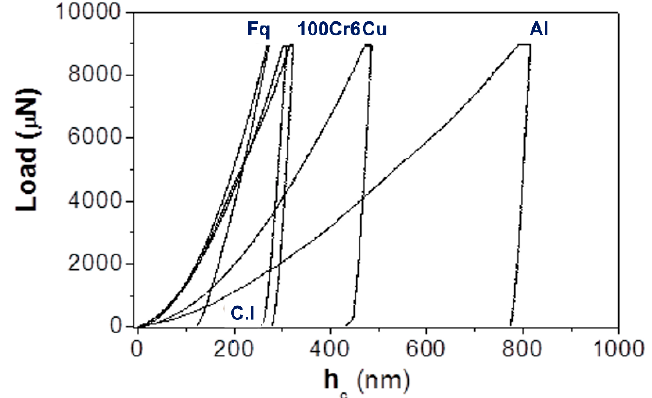
Figure 5. Load ‐ displacement curves (P Max = 9,000 μ N) for Fq, pure Al, DHP Cu, 100 Cr6 steel, grey cast iron.